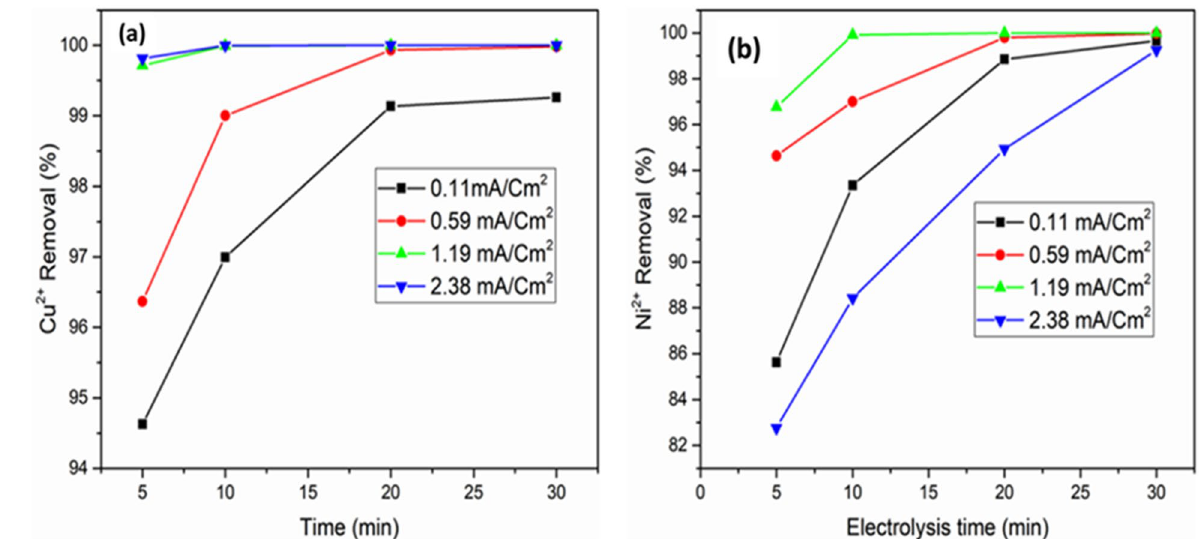
Figure 8. Effect of Current density on ( a ) Cu 2+ and ( b ) Ni 2+ removal of the synthesized wastewater during the ADS and ADS/EC coupling processes (Activated green tea waste dose = 1 g L −1 , pH = 6, Current